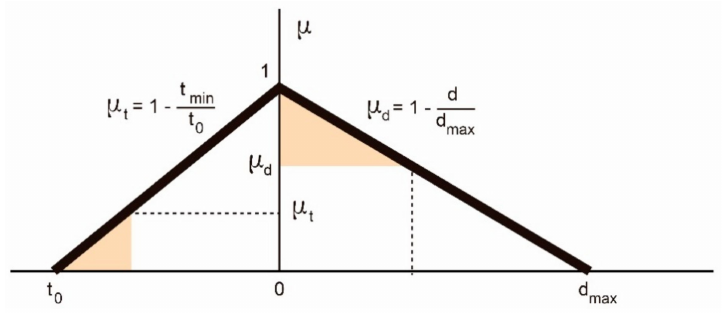
Figure 4. Loss functions associated with thinning and elastic